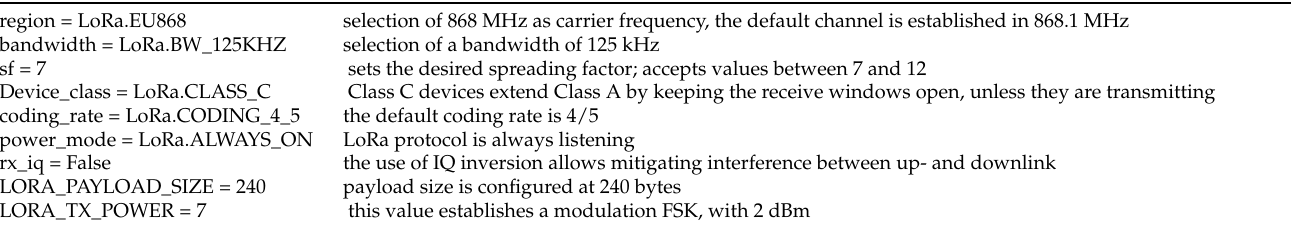
Table 5. Parameters for LoRa